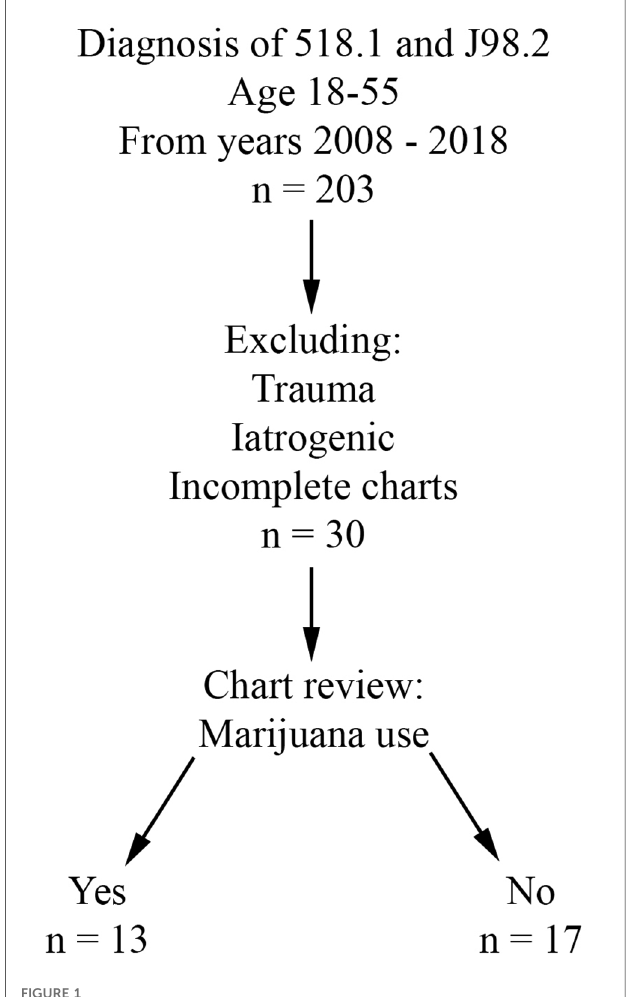
FIGURE 1 Case selection fl